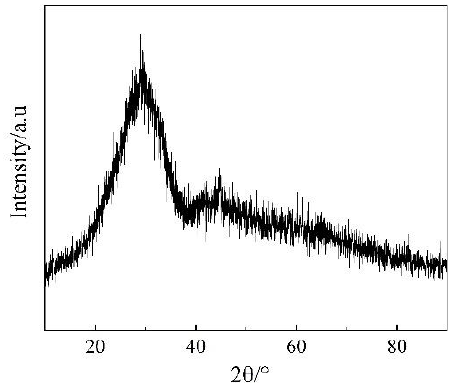
Figure 4. XRD results for base glass #3 .